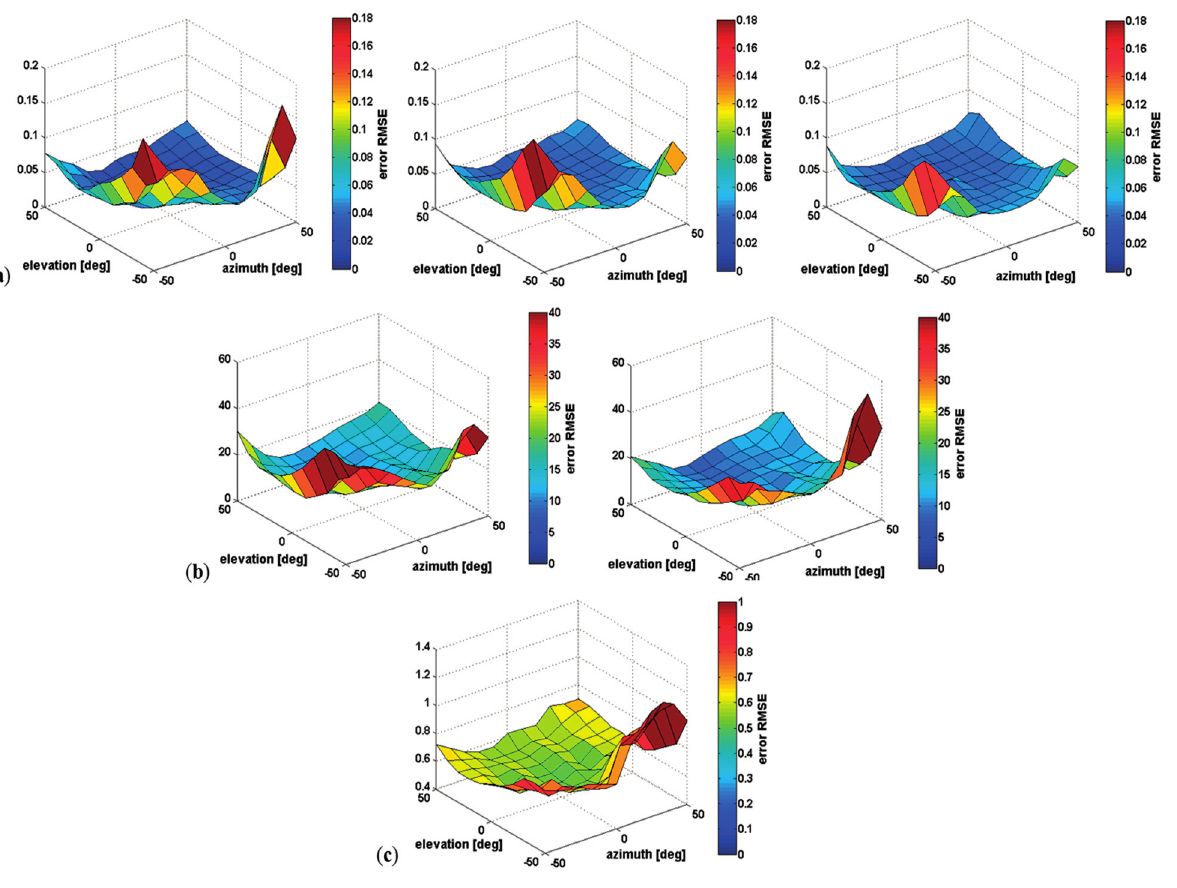
Figure 8. Root mean square error (RMSE) of all poses relative to the sensor placement (azimuth and elevation). ( a ) RMSE distribution of the shoulder (left), elbow (center), and wrist (right) joint positions estimated; ( b ) RMSE distribution of the shoulder (left) and elbow (right) joint angles calculated; ( c ) RMSE distribution of the resulting upper-body RULA